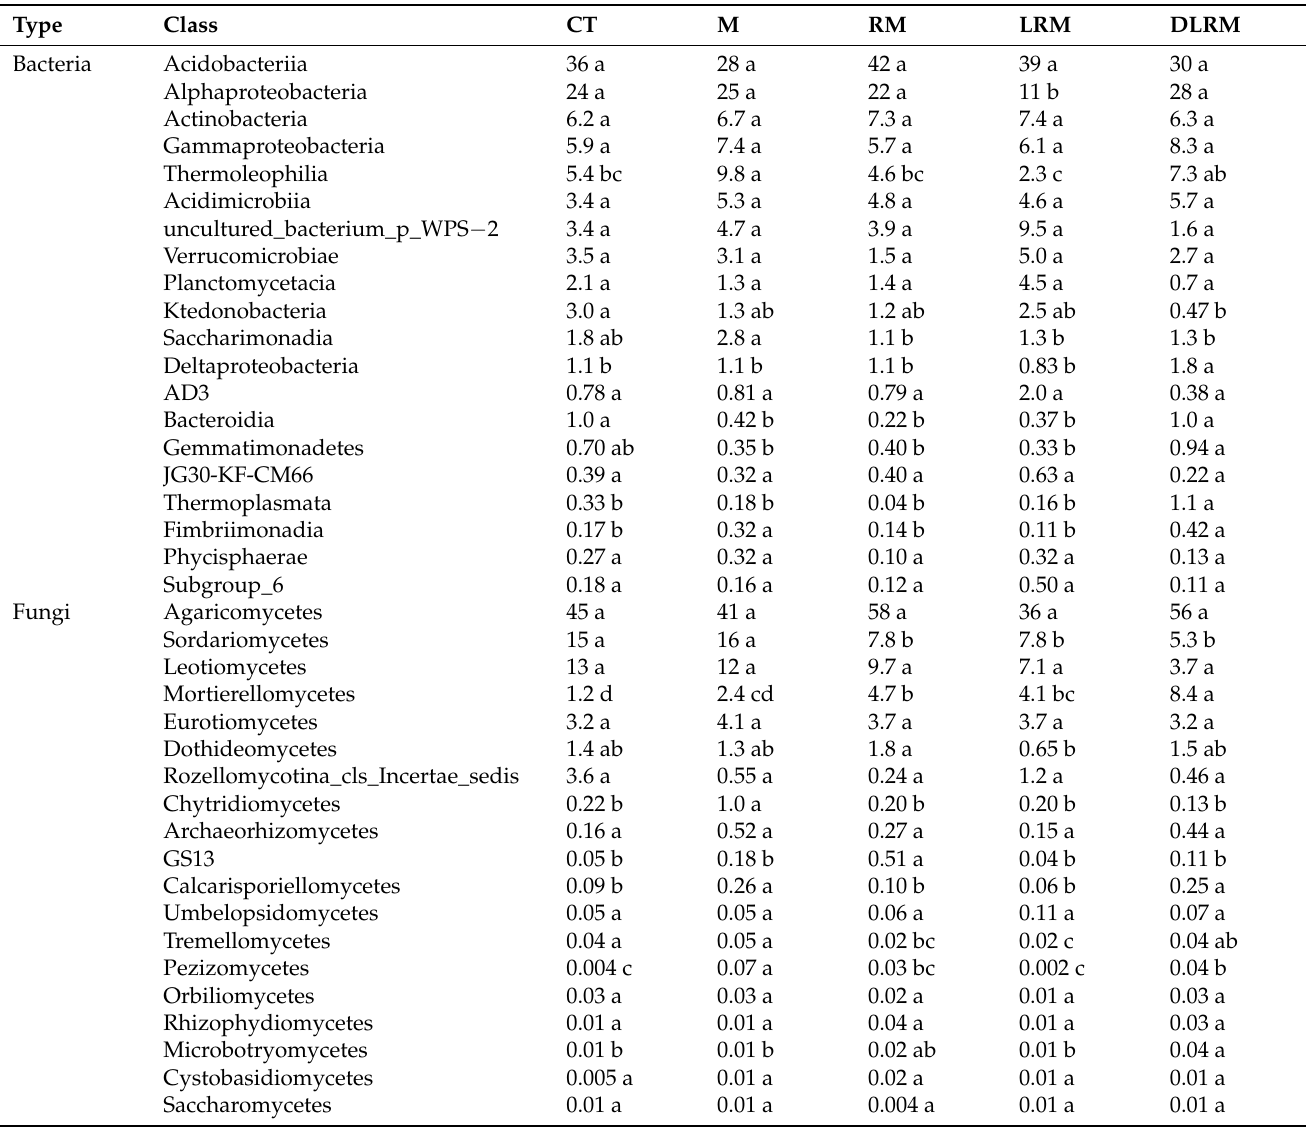
Table 4. Relative abundance of major soil bacteria and fungi at class level in different treatments